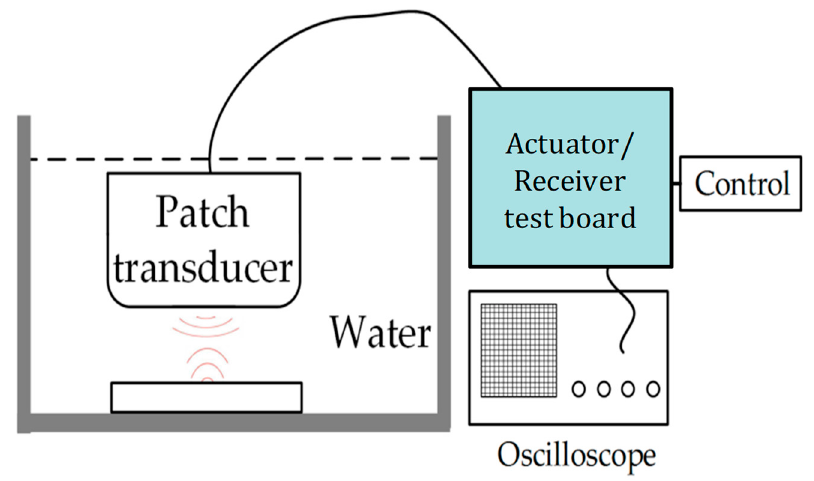
Figure 23. The measurement setup for underwater echo signal acquisition using the actuator/receiver system.